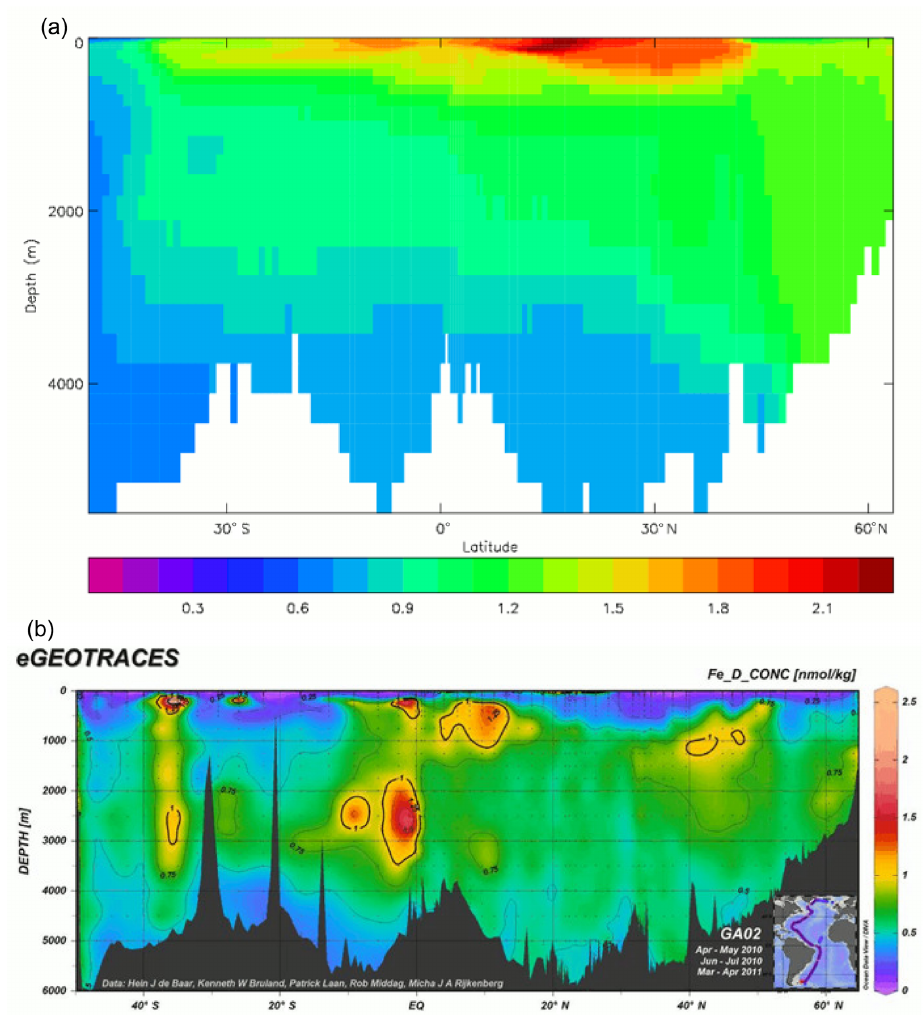
Figure 28. Sections of dissolved iron (µmolFem − 3 ) along the eGEOTRACES GA02 transect (in the Atlantic Ocean): (a) model concentra- tions averaged over the years 2010 to 2019; panel (b) is reproduced from eGEOTRACES.